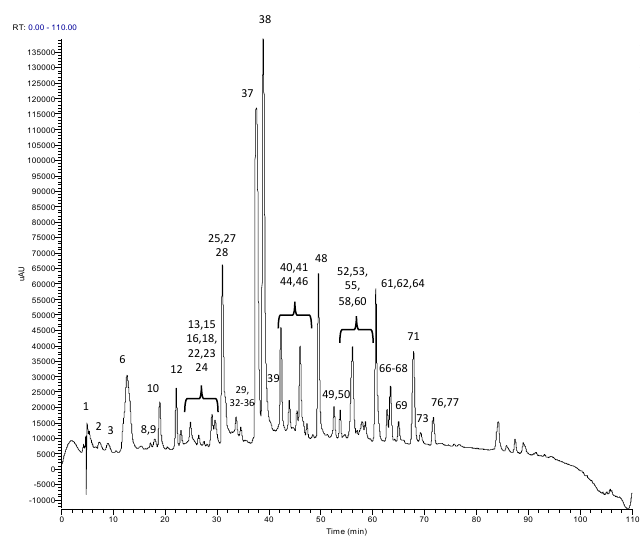
Figure 1. Chromatogram, acquired as total scan Photodiode Array (PDA) Detector, of Oolong GABA (OGABA) extract at 5 mg/mL. Table 2. Chromatographic behavior (retention time, RT), UV, MS and MS/MS data of the compounds identified in GGABA and OGABA extracts.